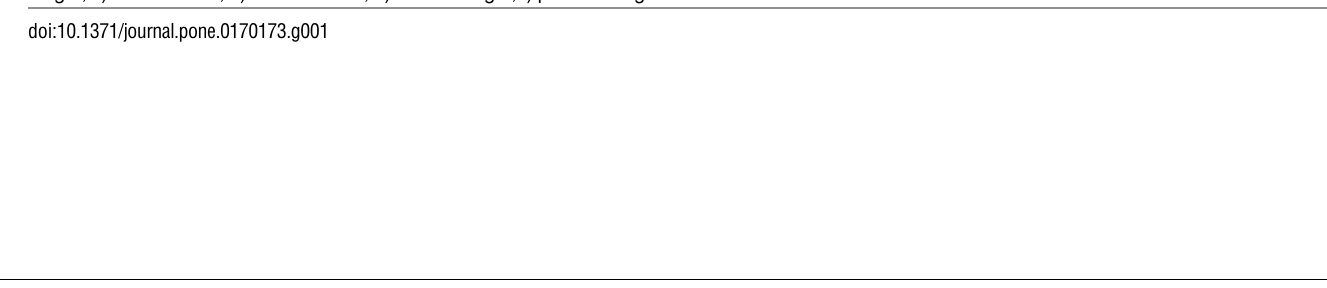
PLOS ONE | DOI:10.1371/journal.pone.0170173 February 16,